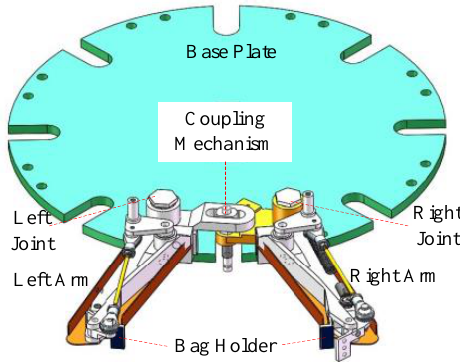
Figure 2. The robotic assembly problem for the automatic packaging machine. The two arms have to rotate to realize the periodic holding and releasing operation. Therefore, the left and right rotational joints have to be installed. Because these joints are coupled with each other, there is a coupling mechanism between them.